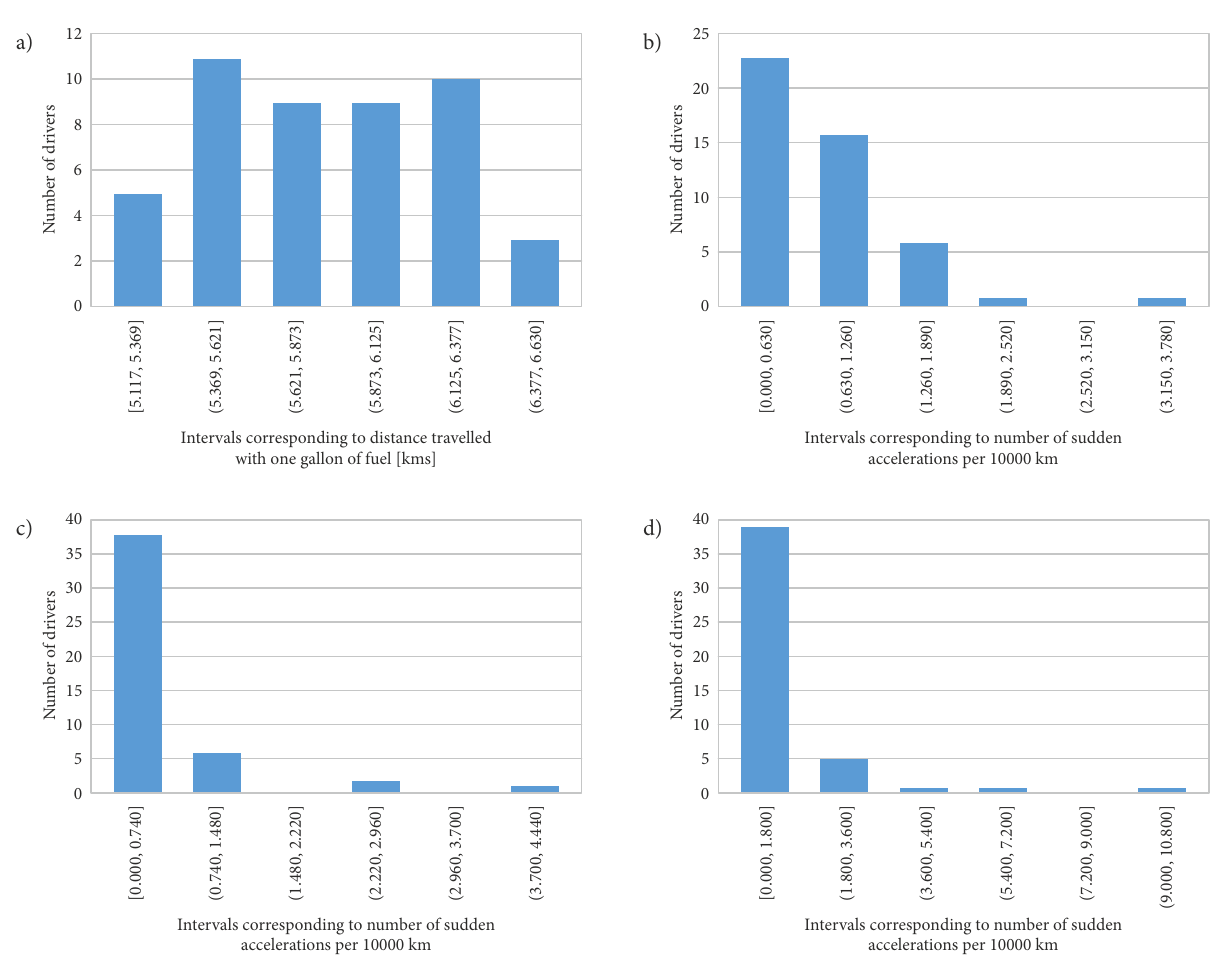
Figure 8. Data distribution for GSI+EBO(R/I) control group: a – distance travelled with one gallon of